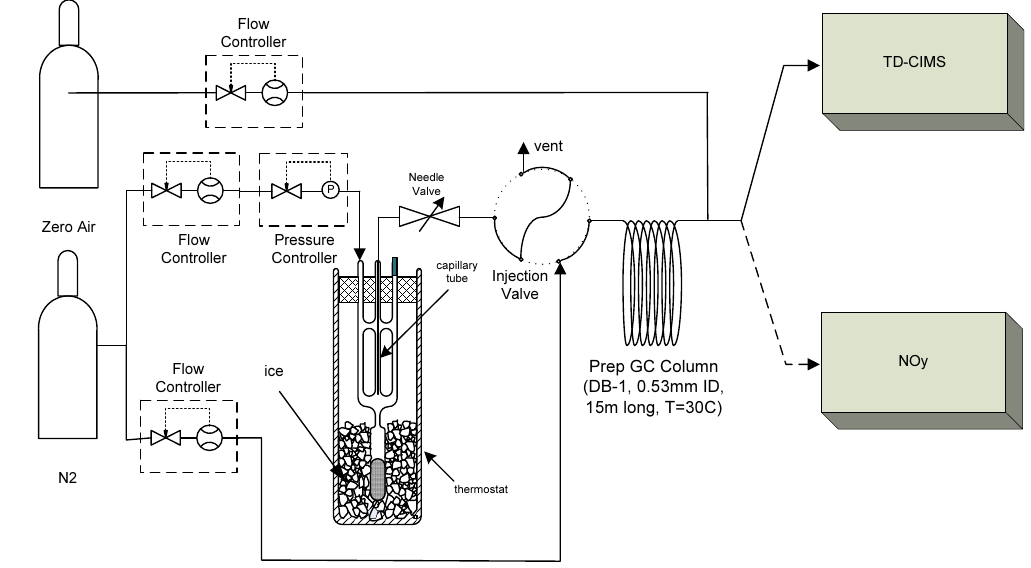
Fig. 2. Diffusion cell and preparative scale GC setup for TD-CIMS calibration.